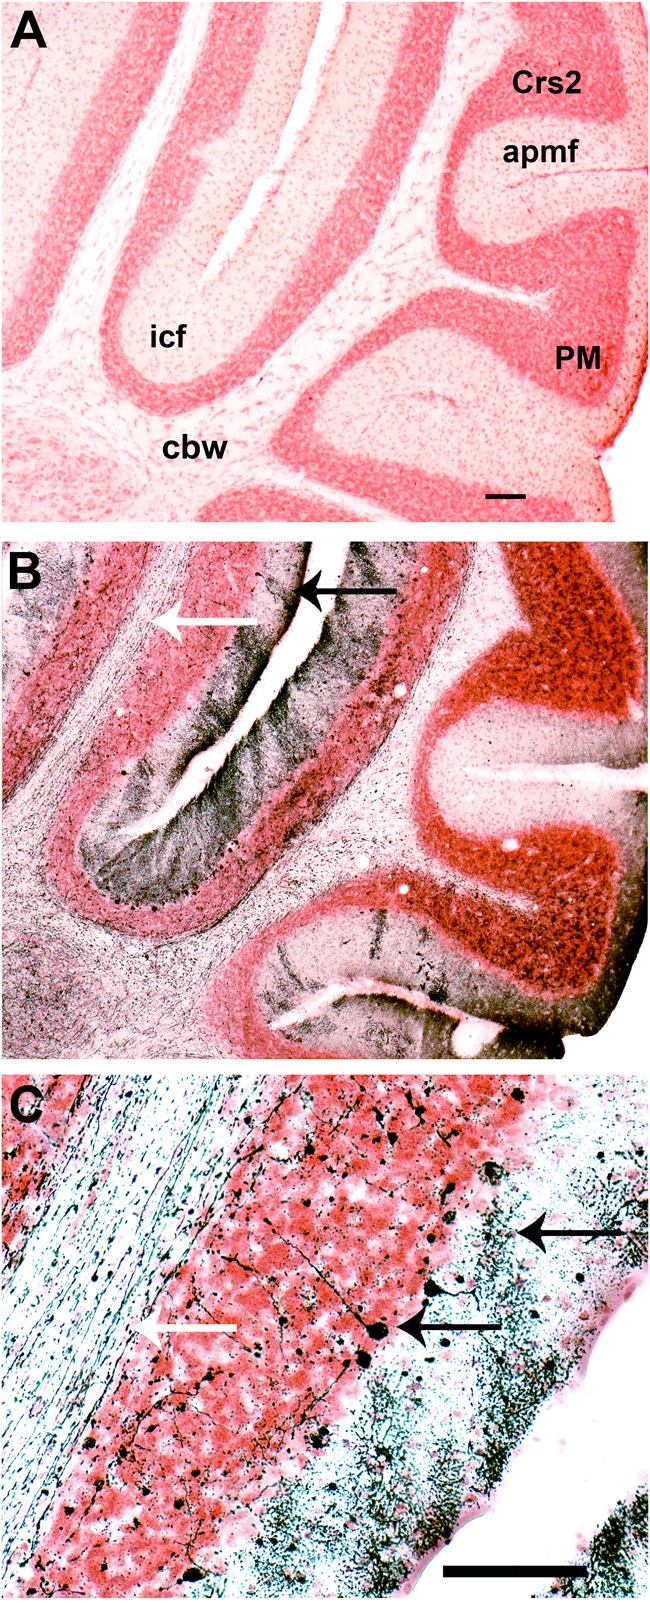
Infection with SLEV CbaAr-4005 induced neurodegeneration in mouse cerebellum. Compared to the brain of uninfected mice (A), degeneration is seen in cerebellum fibers of mice sacrificed at day 11 PI (B,C; white arrows), and degenerated dendrites were identified (B: black arrow; C: upper black arrow). Purkinje cells underwent somatodendritic degeneration in the cerebellum (C: lower black arrow). This figure is representative of three independent experiments. Crs2, crus 2 of the ansiform lobule. apmf, ansoparamedian fissure. icf, intercrural fissure. PM, paramedian lobule. cbw, cerebellar white matter. Sagittal section Lat 2.62 Bar = 100 μm (A,B); Bar = 50 μm (C).